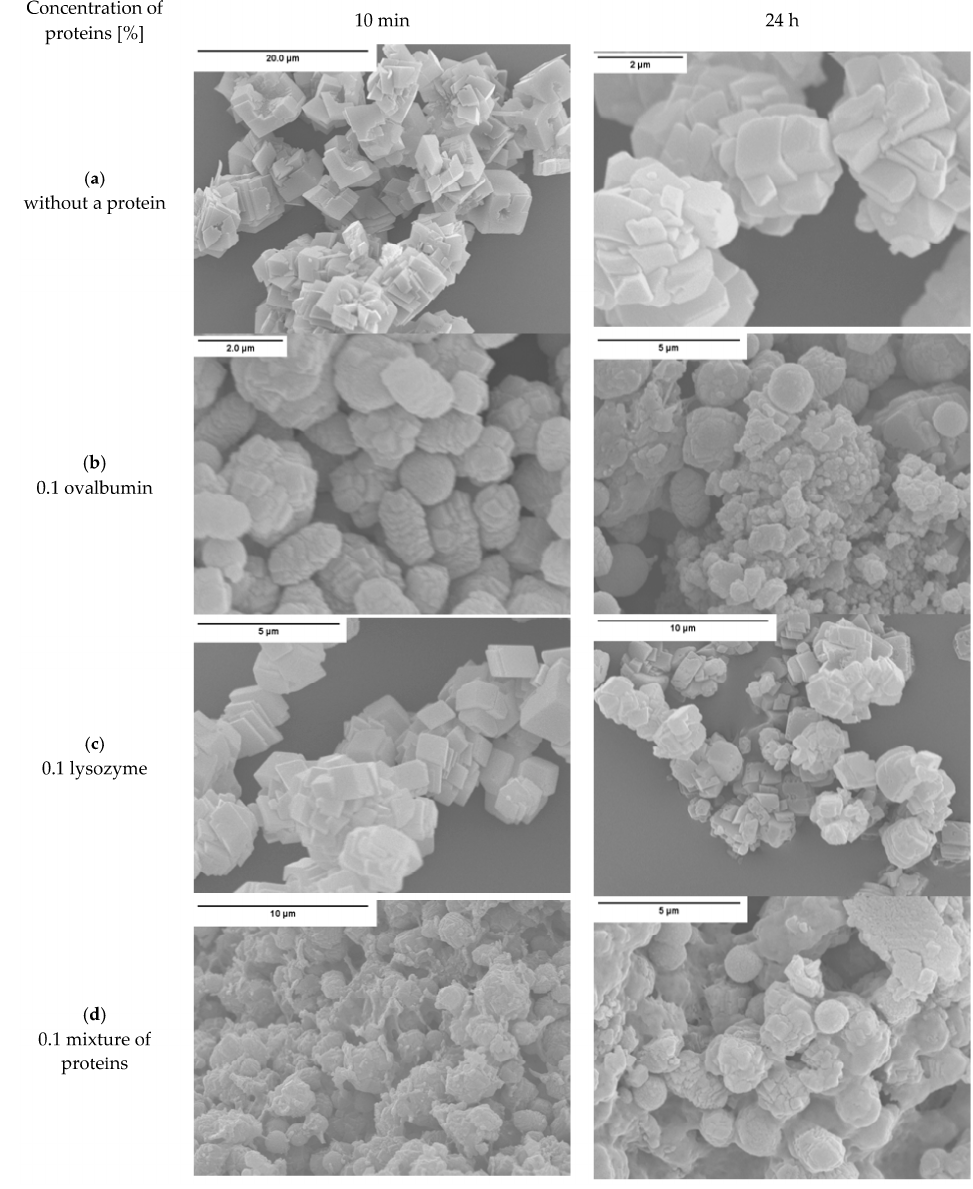
Figure 2. SEM images of CaCO 3 obtained in the presence of: ( a ) no protein; ( b ) ovalbumin; ( c ) lysozyme; and ( d ) mixture of proteins.